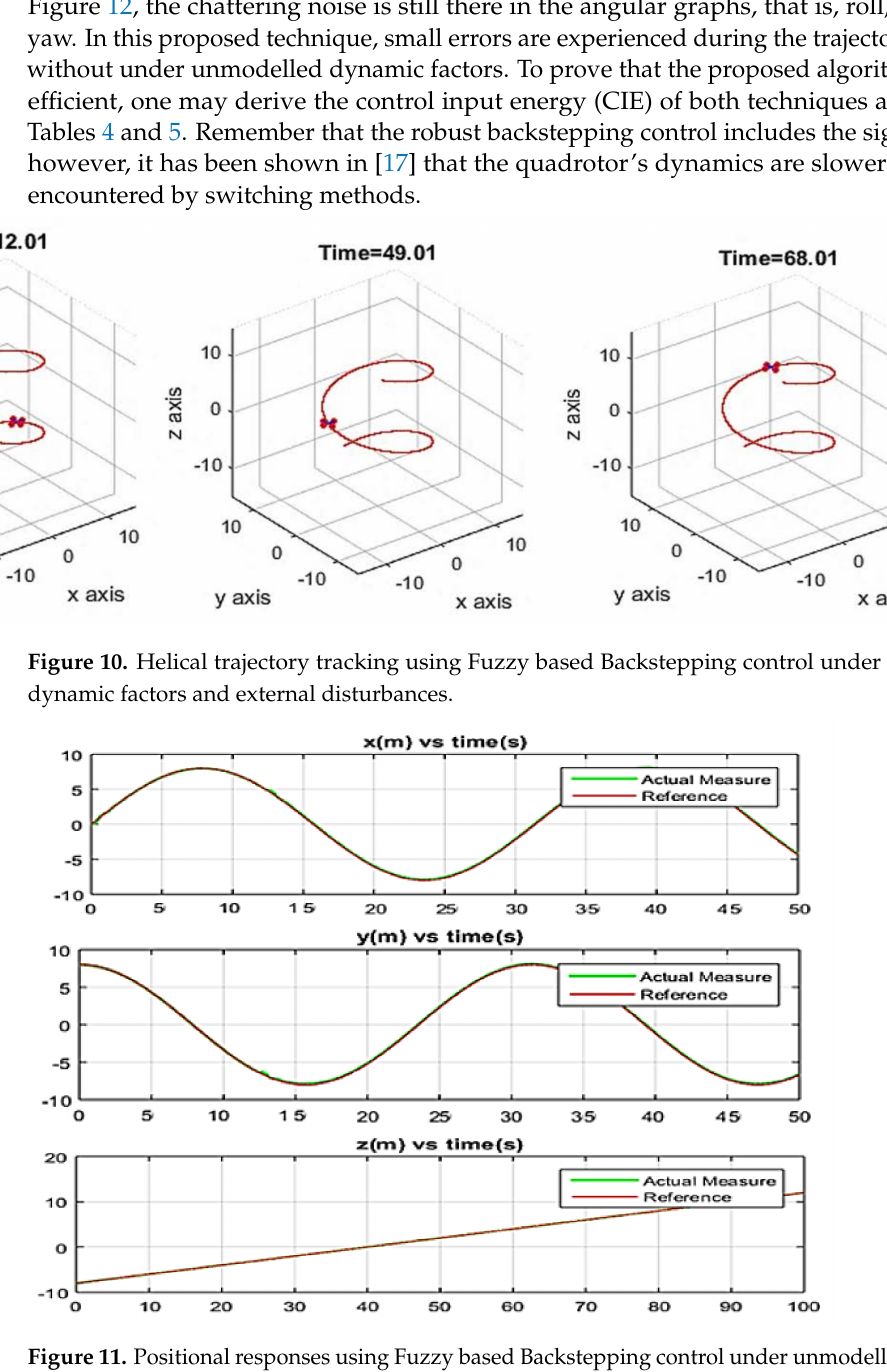
Figure 11. Positional responses using Fuzzy based Backstepping control under unmodelled dynamics and external